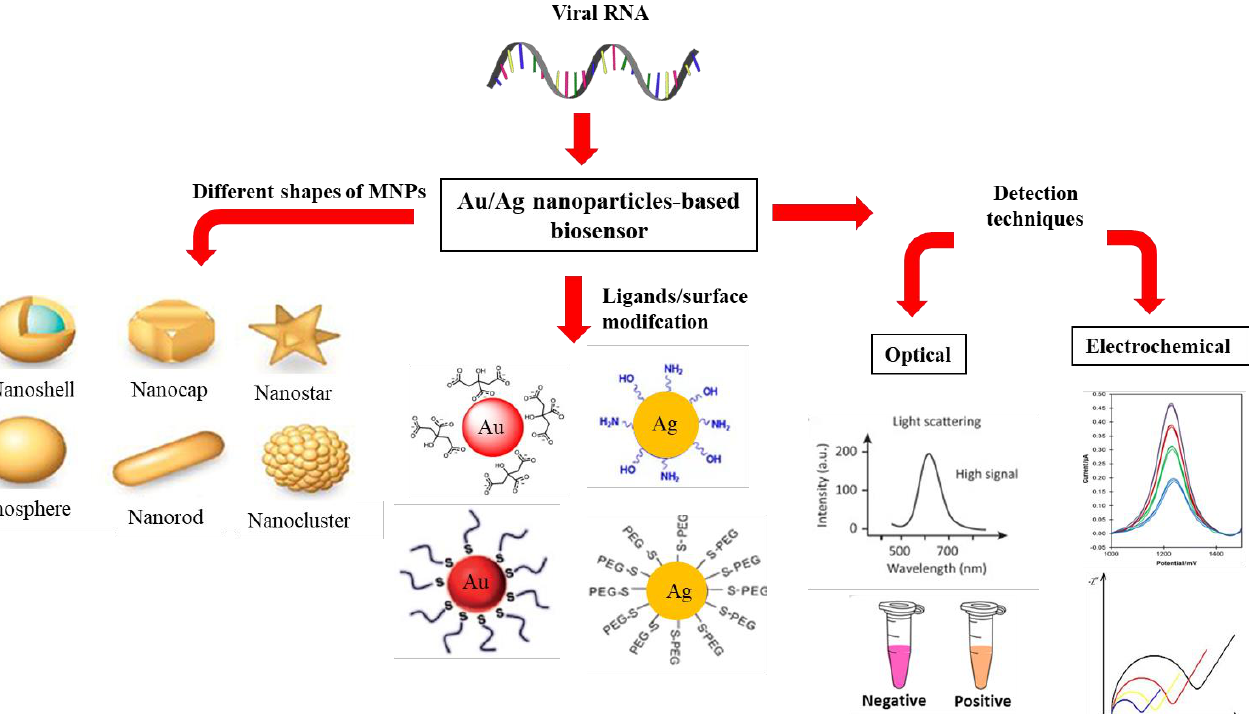
Figure 1. The schematic figure that represents the different shapes of MNPs (AuNPs or AgNPs) and the use of ligands to stabilize the MNPs. The optical and electrochemical properties of the MNPs have been validated by using the optical and electrochemical sensing techniques.